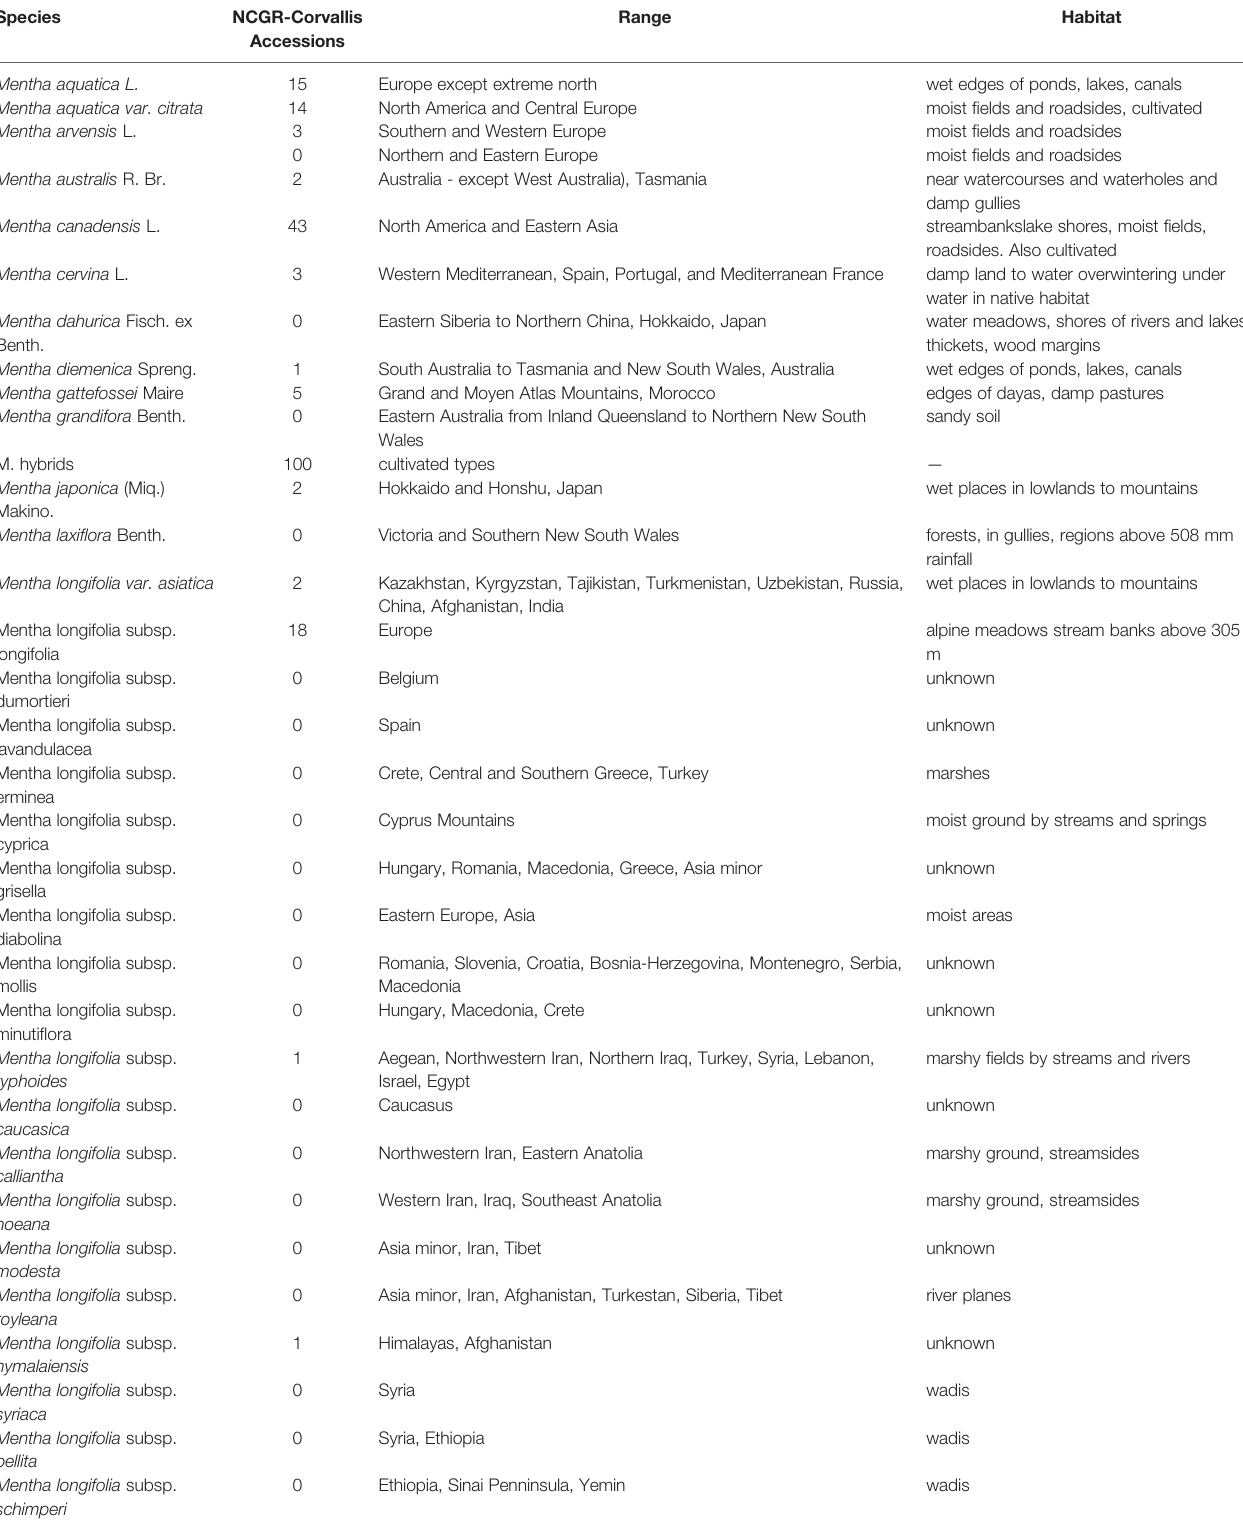
TABLE 3 | Mentha L. species, distribution, habitat, and number of accessions in the USDA ARS National Clonal Germplasm Repository-Corvallis.